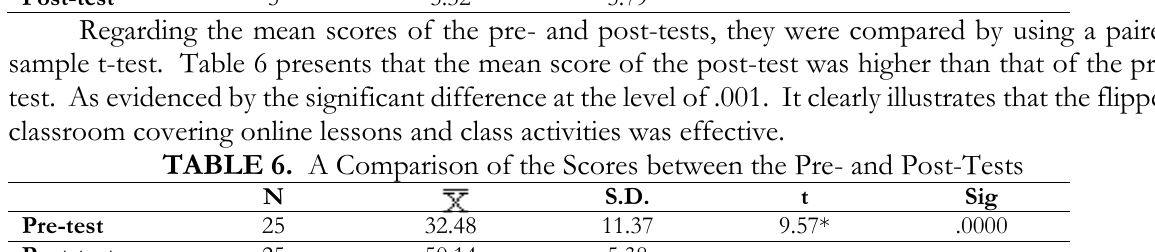
TABLE 5. A Comparison of the Percentage of the Occurrences of Errors between the Pre- and Post-Tests N S.D. t Sig Pre-test 5 7.77 Post-test